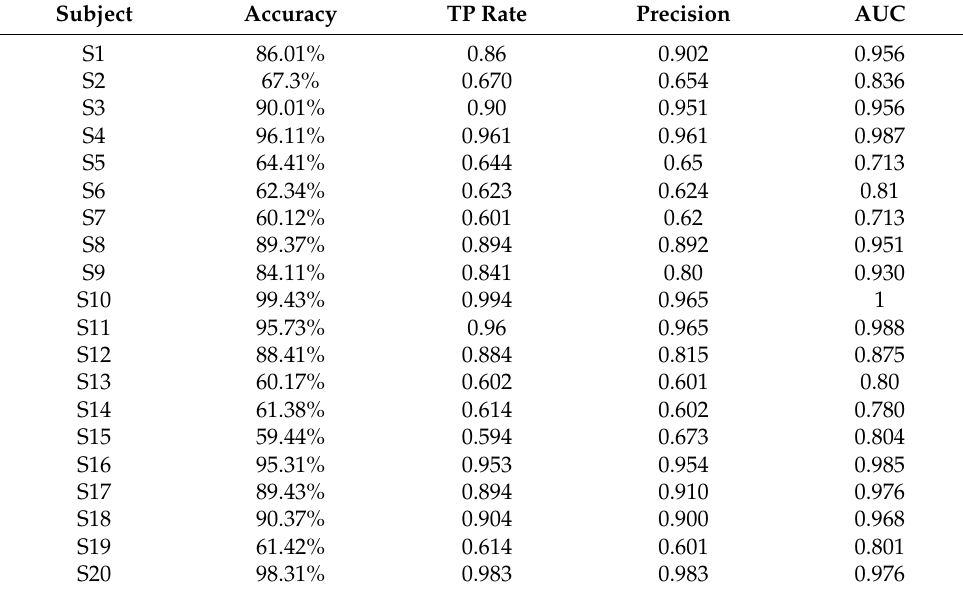
Table 2. Experimental analysis of EEG data by using Random Forest